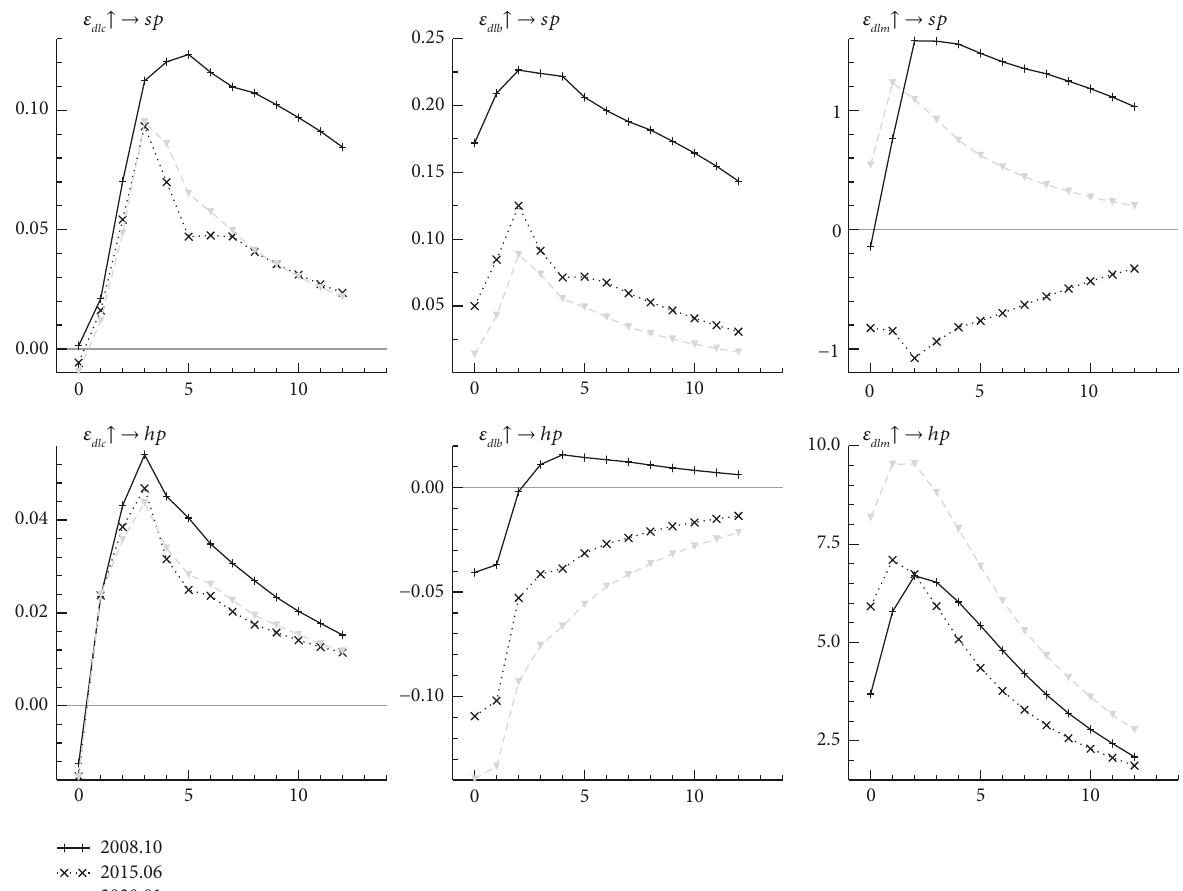
Figure 10: Impulse responses of liquidity to asset price volatility at different time